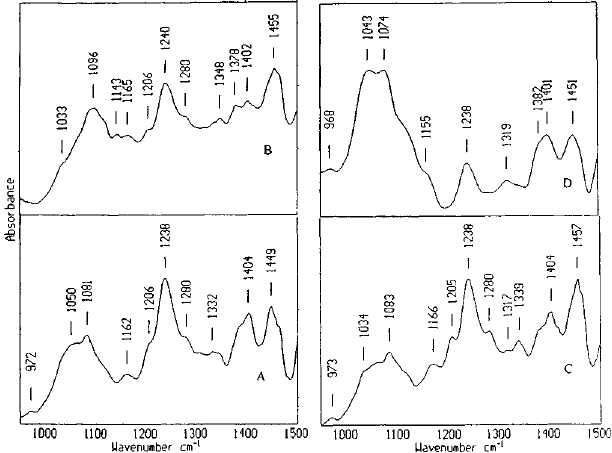
Fig. 3. This figure shows the significant differences among the representative FTIR spectra in the frequency region 950 to 1500 cm (cid:0) 1 of